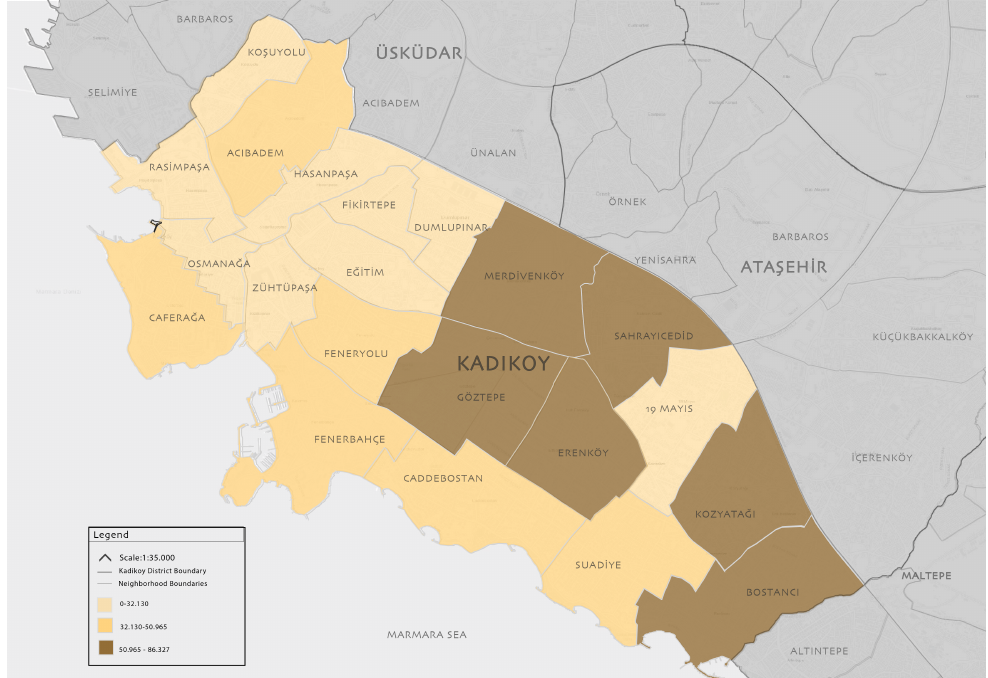
Figure 2. Population Classification (Equal Interval) of Neighborhoods in Kadikoy District (map was produced based on demographic database of TUIK, 2019 [54]).